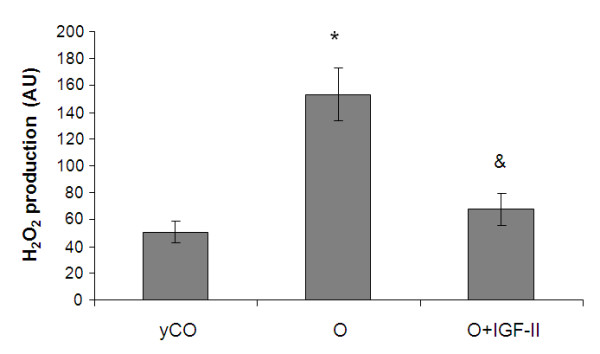
Intramitochondrial H2O2 production in isolated mitochondria from the three experimental groups.